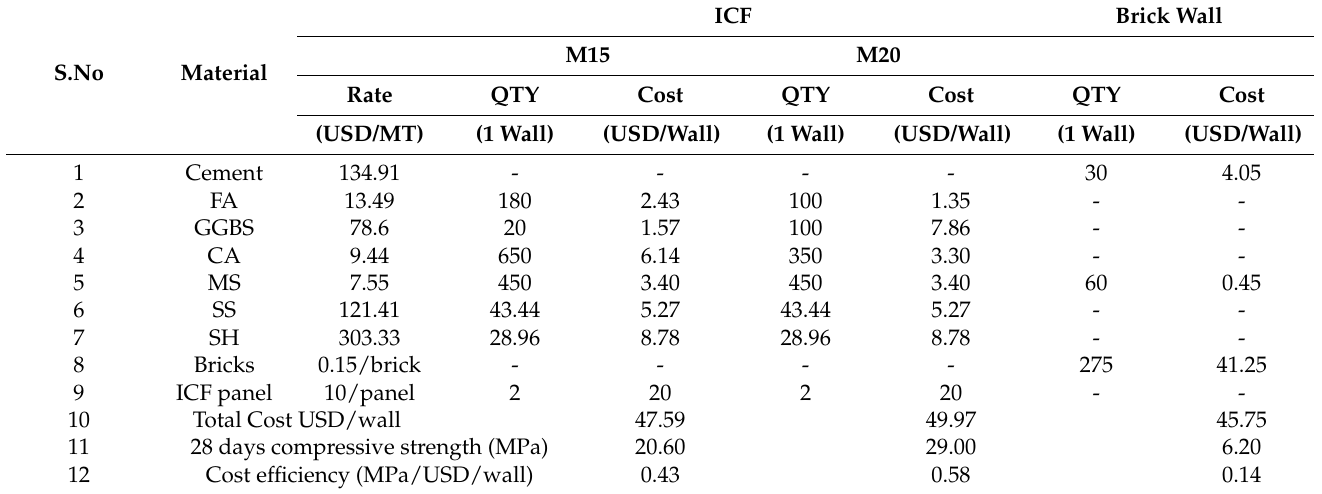
Table 5. Cost-efficiency analysis of ICF and brick walls.